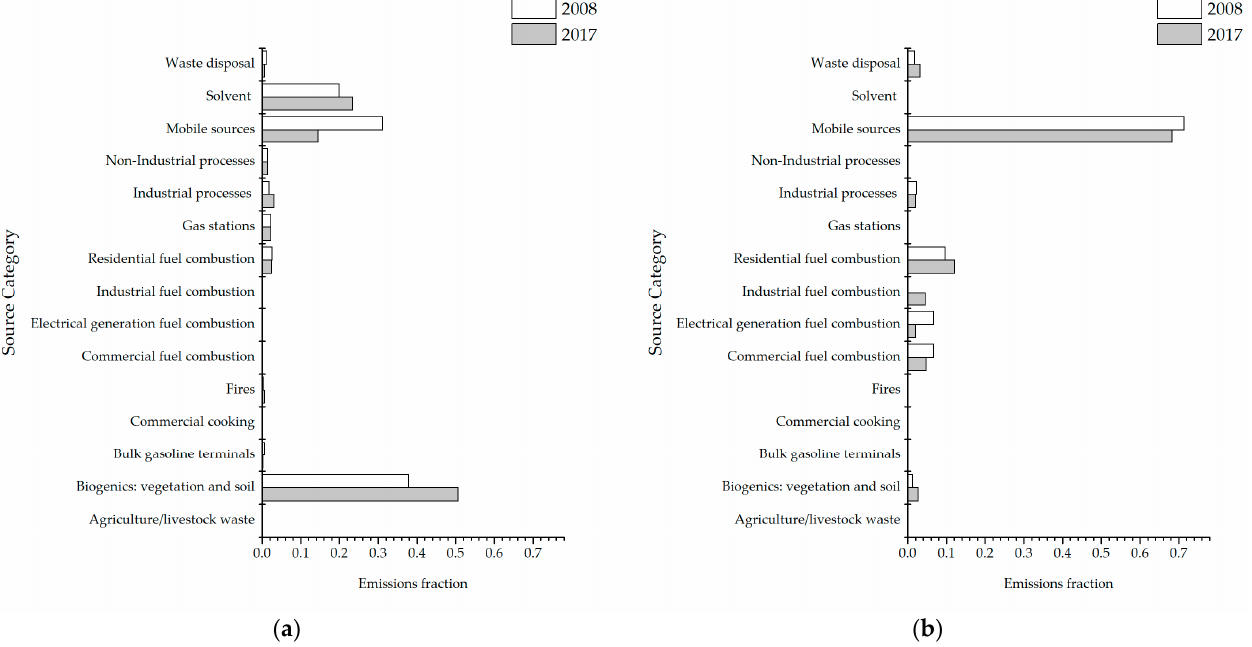
Figure 5. The relative abundance of ( a ) VOCs and ( b ) NO x by source category in NY, NJ and CT in 2008 and 2017. 2008 and